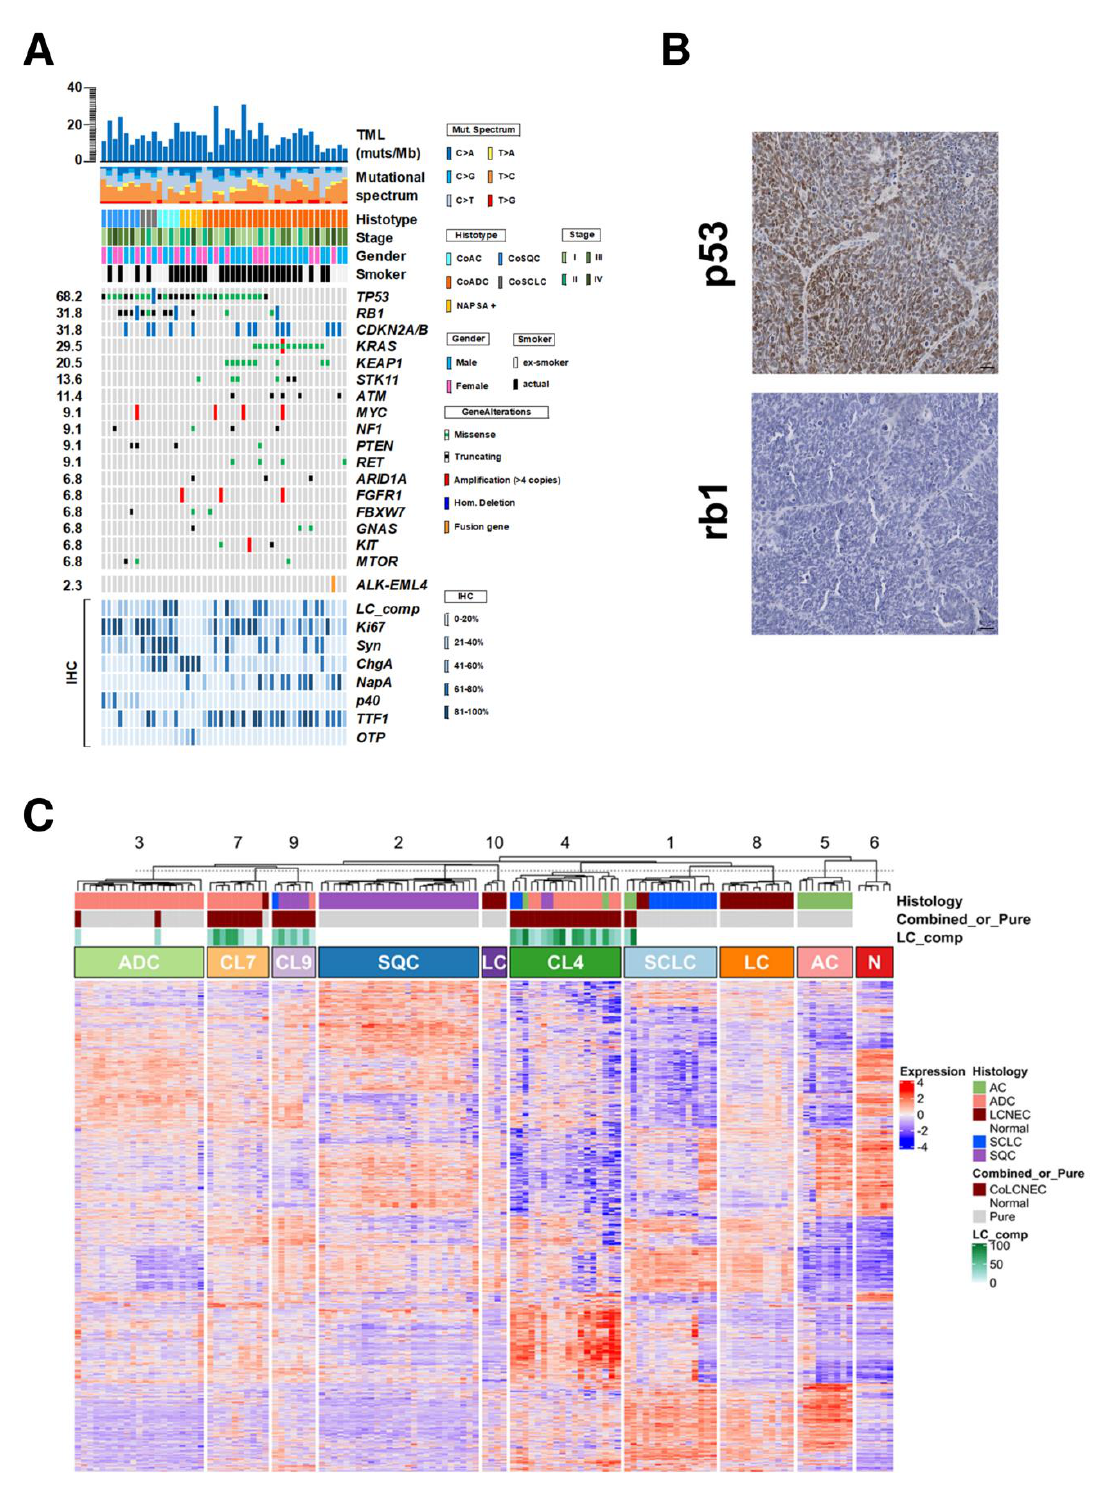
Figure 2. Genomic landscape of 44 combined-LCNECs and gene expression analysis of lung cancer subtypes. ( A ) The upper histogram shows the tumour mutational load. The central matrix shows the 17 genes that were altered at sequencing analysis in at least 3 cases and the fusion transcript identified. Genes are listed according to the frequency of alterations. The bottom matrix shows the proportion of large cell components (LC_comp) and immunopositivity for the indicated markers observed for each sample. ChgA (Chromogranin A); Syn (Synaptophysin); NapA (Napsin-A); p40 (deltaNp63); TTF-1 (thyroid transcription factor 1); OTP (orthopedia homeobox protein). ( B ) Representative